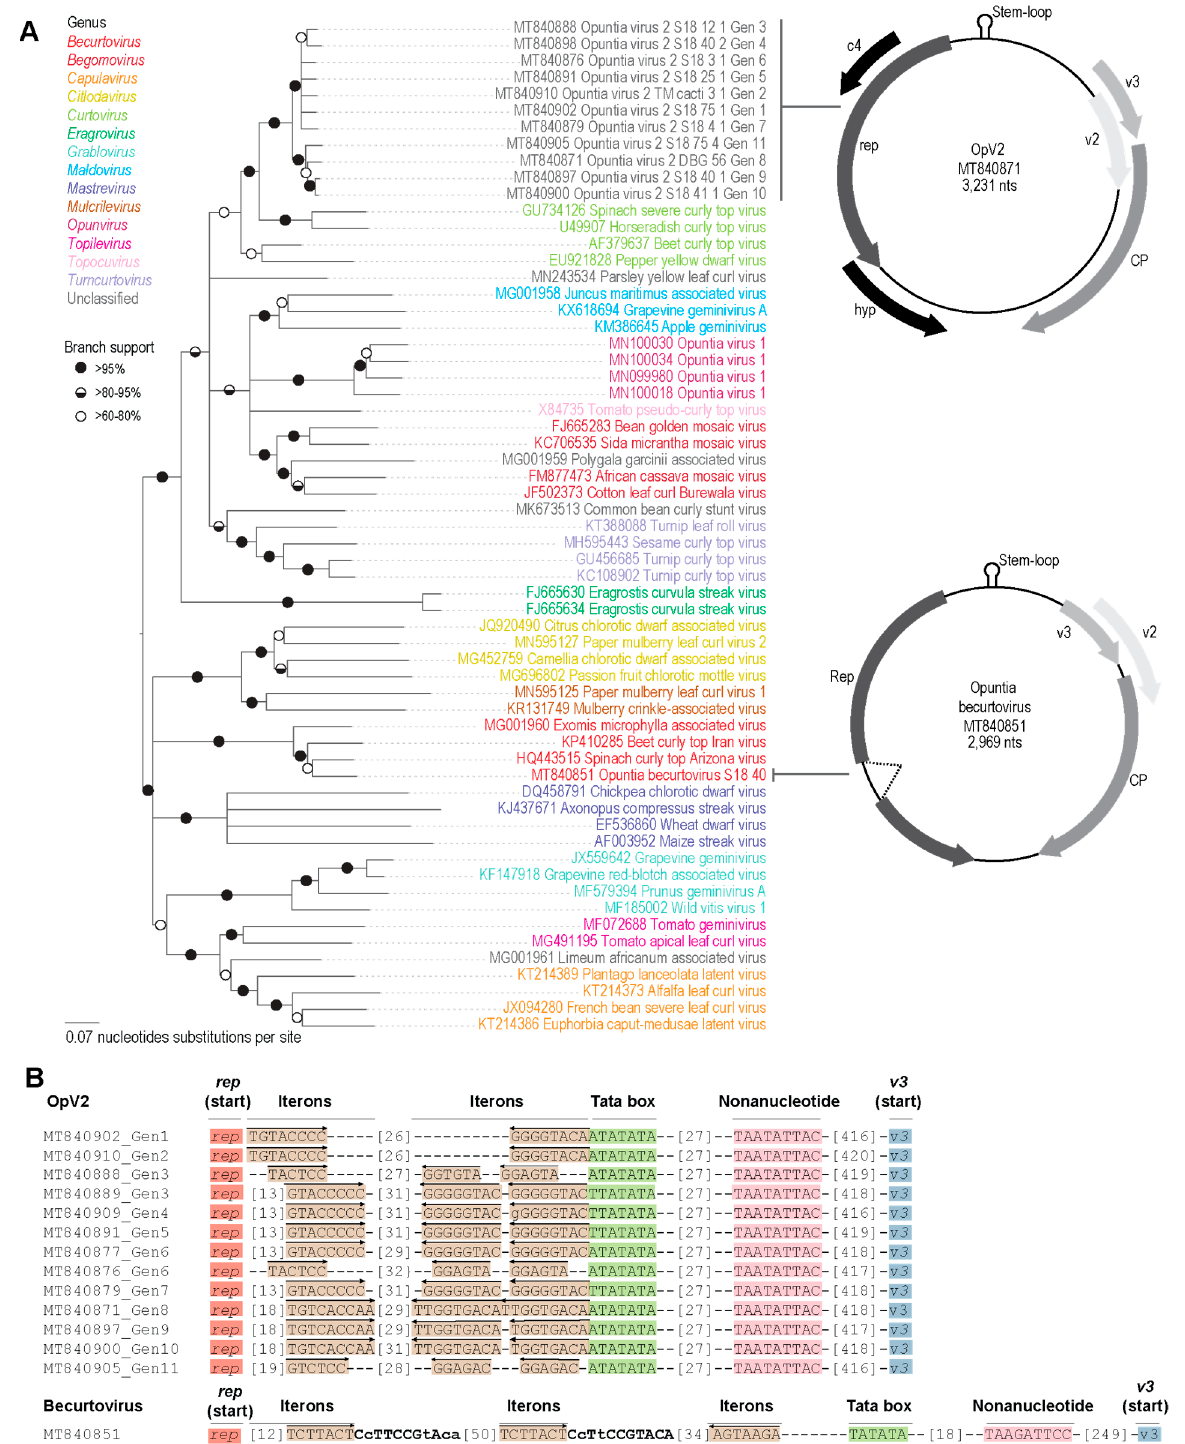
Figure 1. ( A ) Neighbor-joining phylogenetic tree of the genome sequences of the eleven genotypes of OpV2 and the Opuntia becurtovirus, together with representative sequences from various genera in the family Geminiviridae . Branches with <60% bootstrap support have been collapsed and the phylogenetic tree is midpoint-rooted. The genomic organization of OpV2 and the Opuntia becurtovirus are illustrated on the right side of the phylogenetic tree near their respective groups. ( B ) Organization and orientation of the replication-associated interactive sequences “iterons” in the intergenic region of both eleven genotypes of OpV2 and the Opuntia becurtovirus. The arrows indicate the orientation of the iteron sequences relative to the nonanucleotide and lower-case letters indicate that the nucleotide is variable among sequences in that genotype. Some genotypes presented more than one type of “iteron” sequence.